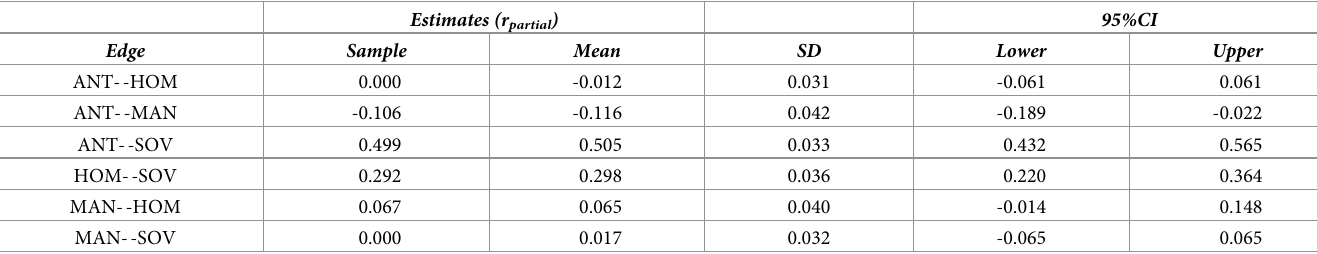
Table 3. Sample and bootstrap mean of edge-weights of the populist ideology dimensions network. Estimates (r partial ) 95%CI Edge Sample